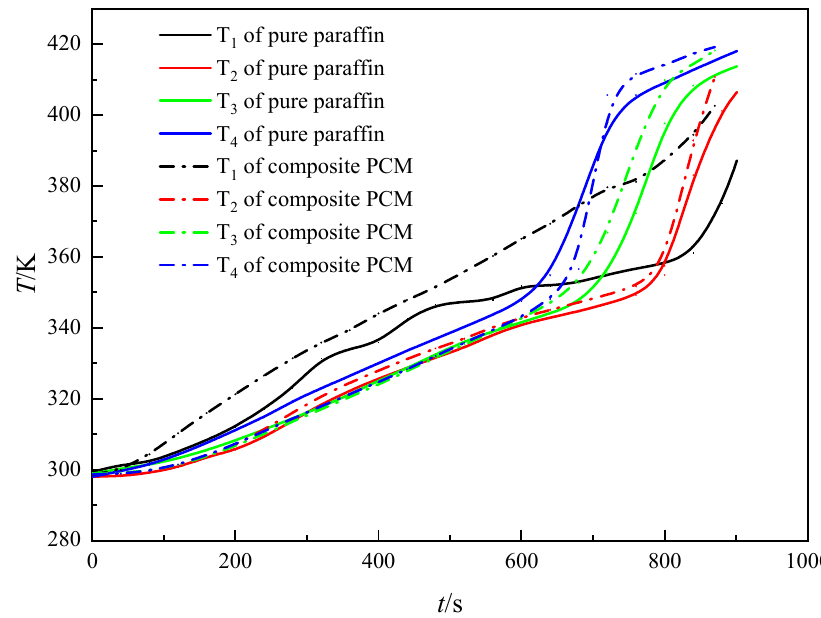
Figure 8. Temperature distribution at different temperature measuring points in